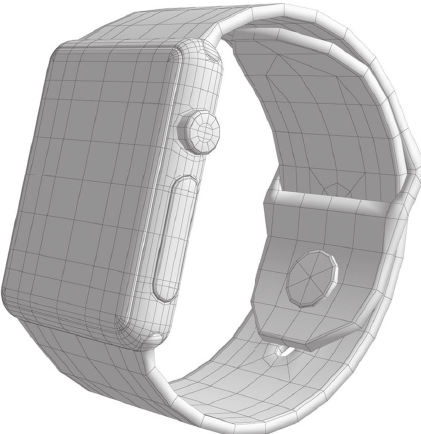
Figure 1: Smartwatch typical design.